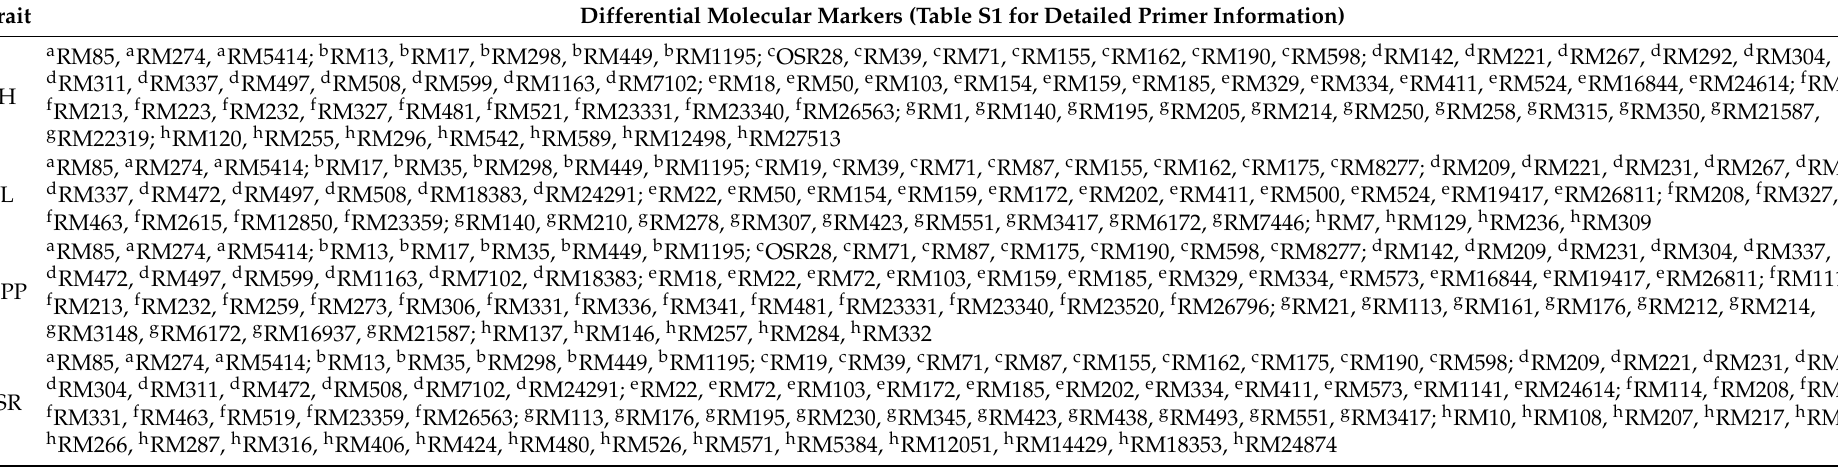
Table 3. Molecular markers of eight different agronomic